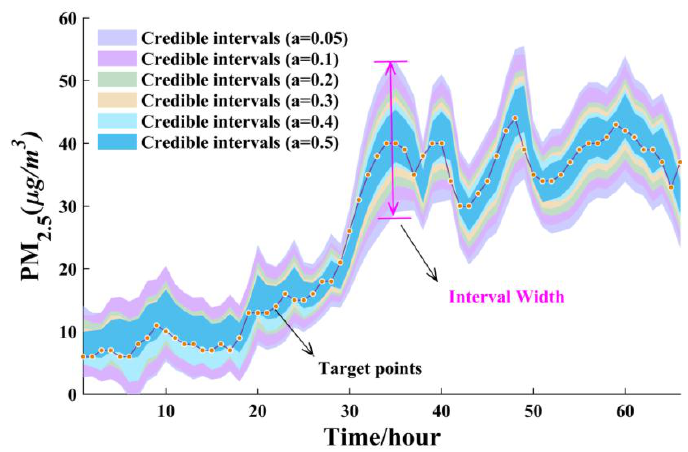
Figure 8. The width of interval forecasting with different significance levels ( a ).